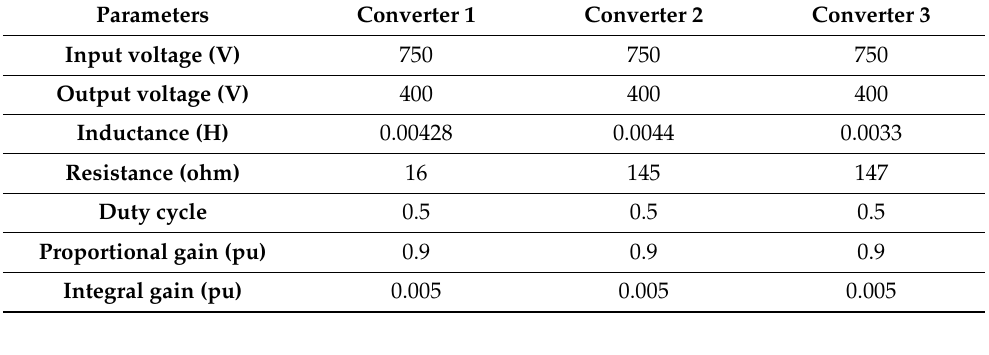
Table 4. Parameters of the DC–DC buck converters.